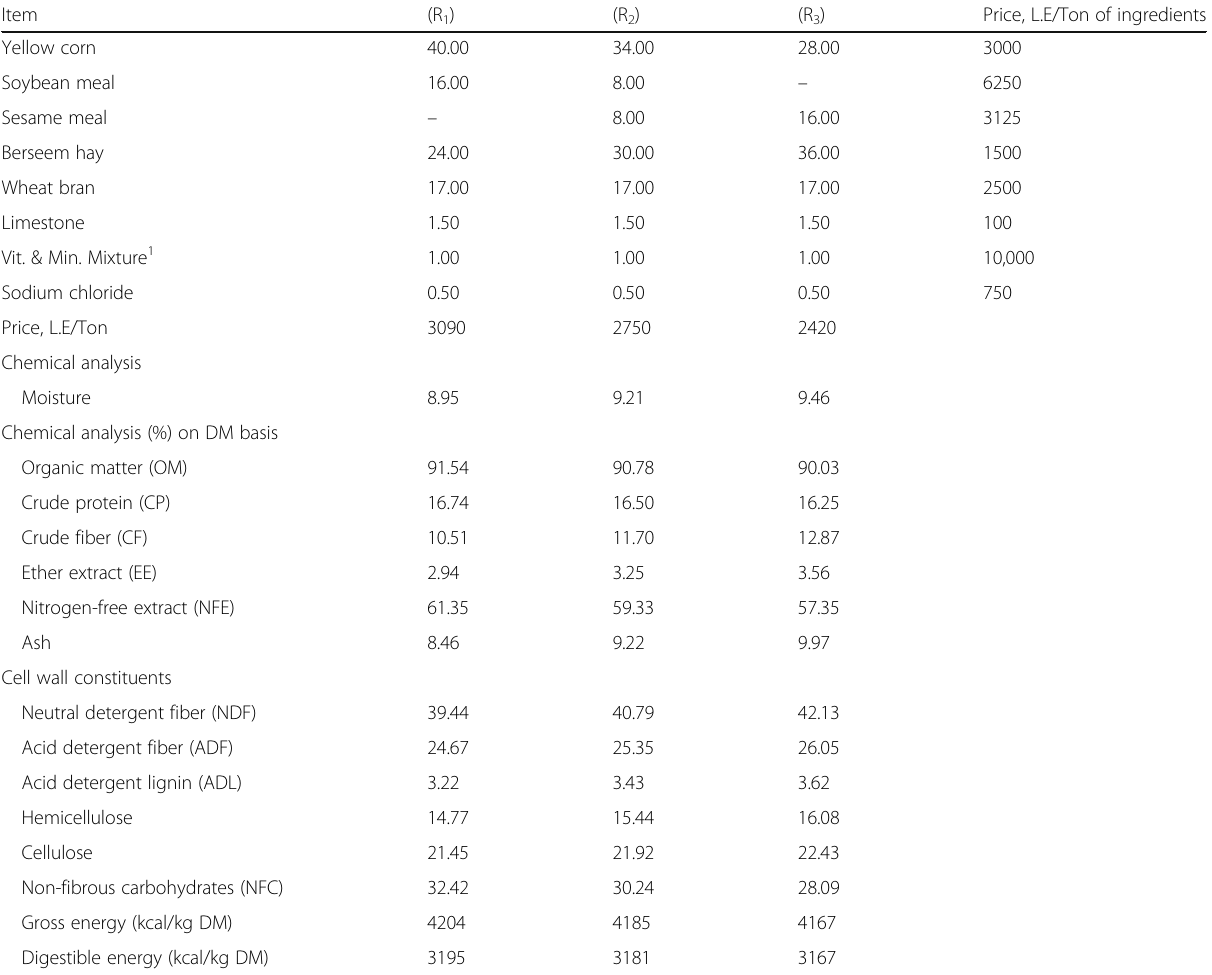
Table 2 Composition and chemical analysis of rations used in lamb feeding Item (R 1 ) (R 2 ) Yellow corn Soybean meal Sesame meal